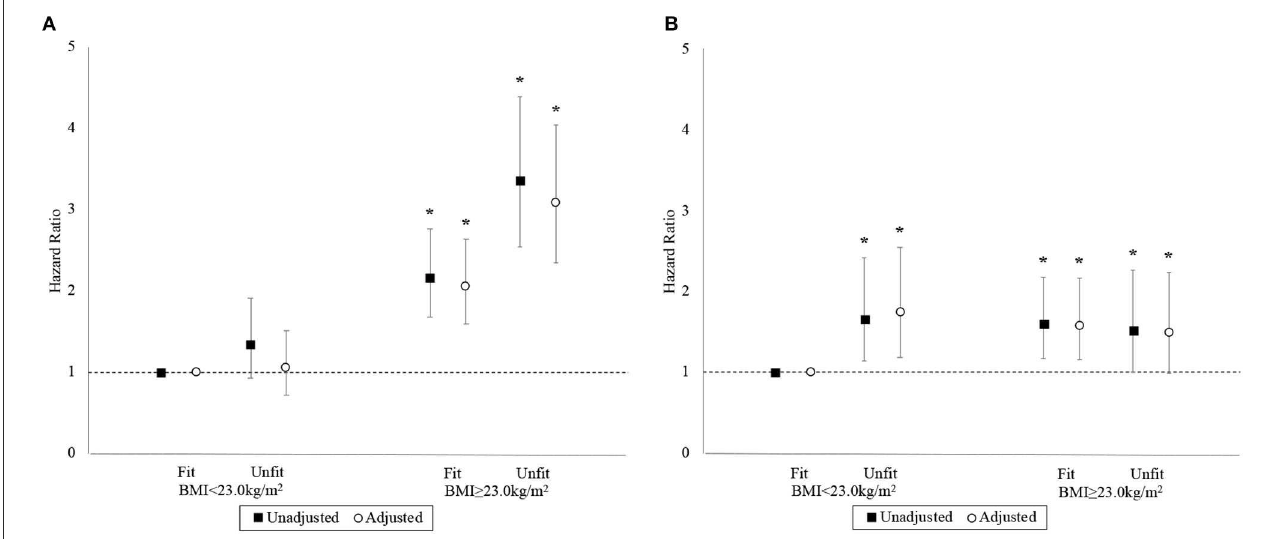
FIGURE4 Hazard ratios with 95% confidence interval by BMI-fitness category. Panels (A, B) correspond to the MACE and ACM outcomes, respectively. Basic adjustments also included the year of BMI measurement and age at time of entry into the study period as predictors in the models. An asterisk (*) denotes a hazard ratio that is significantly different from 1 (i.e., p <